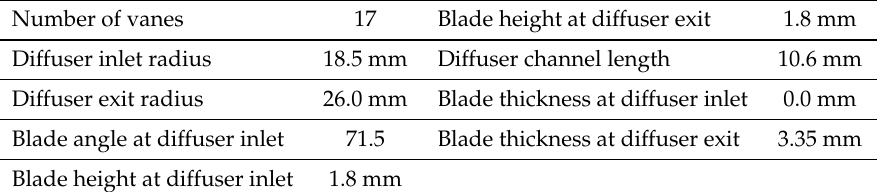
Table 2. Geometry details of the vaned